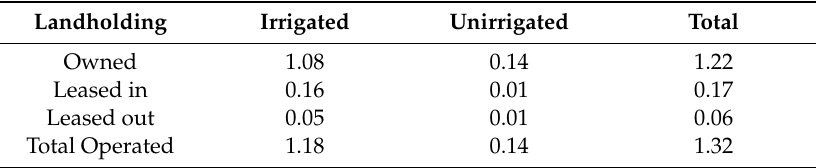
Table 4. Landholding profile-mean (hectares).